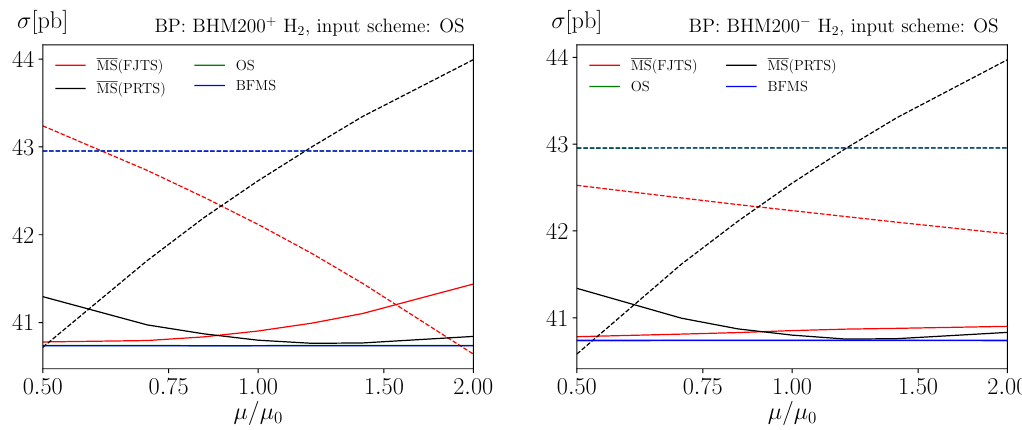
Figure 4 . Scale dependence for light-Higgs-boson production in Higgs-strahlung, pp X , for the HSESM benchmark scenarios BHM200 + (left) and BHM200 (cid:0) (right) in di(cid:11)erent renor- malization schemes, with the OS scheme as input scheme (and full conversion of the input param- eters into the other schemes). LO results are shown as dashed, NLO as full lines; the central scale is set to (cid:22) 0 = M H . 2